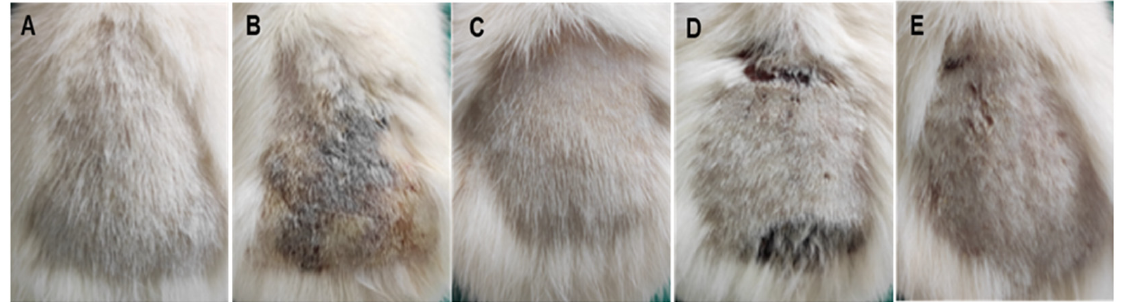
Figure 8. Representative photos of gross examination for representative rat skin of ( A ) Group I (neg- ative control, shaved animal skin was not swapped with S. aureus, and without applying any tested samples), revealed normal skin; ( B ) Group II (positive control, animal skin was swapped only with S. aureus, and remained untreated), which revealed thickening, scaly dark-colored skin with a deep peeled ulcer covered by crust; ( C ) Group III (shaved animal skin was swapped with S. aureus fol- lowed by swapping with ZnO-NPs group), which revealed normal skin appearance without any signs of inflammation and was identical to negative control; ( D ) Group IV (shaved skin was swapped with S. aureus and then swapped with 3% PVP) showed scaly thick ulcerated skin similar to positive control; and ( E ) Group V (shaved animal skin was swapped with S. aureus and then swapped with Sterillium), which revealed mild erythema with mild scales formation. 3.4.1. Histopathological Findings The histopathological findings were identified and scored and are presented in Fig- ure 9 and Table 5. The skin of Group I (negative, untreated group) appeared histopatho-